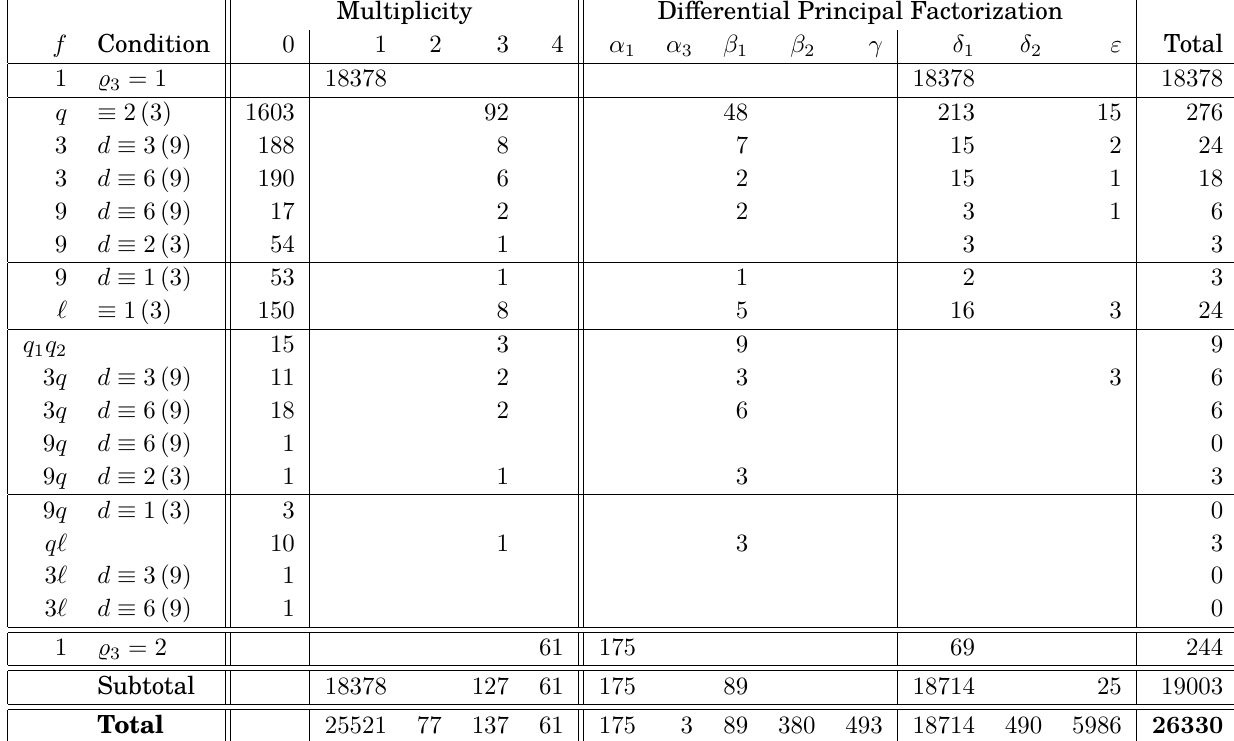
Table 11: Table 10 with 0 < d L < 5 · 10 5 continued for (cid:37) 3 ≥ 1 .